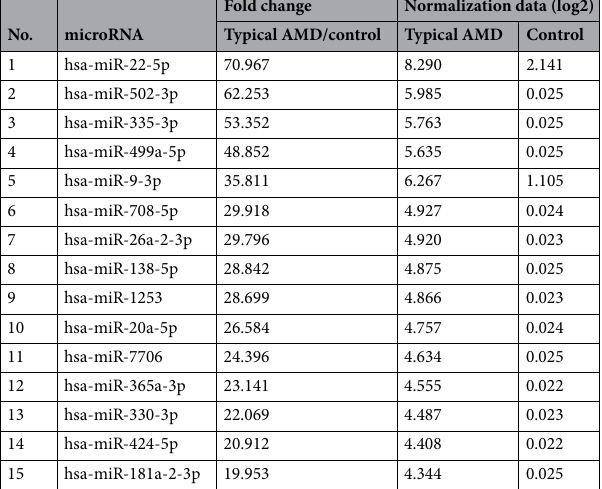
Table 2. Top 15 upregulated miRNAs in typical AMD. AMD age-related macular degeneration.